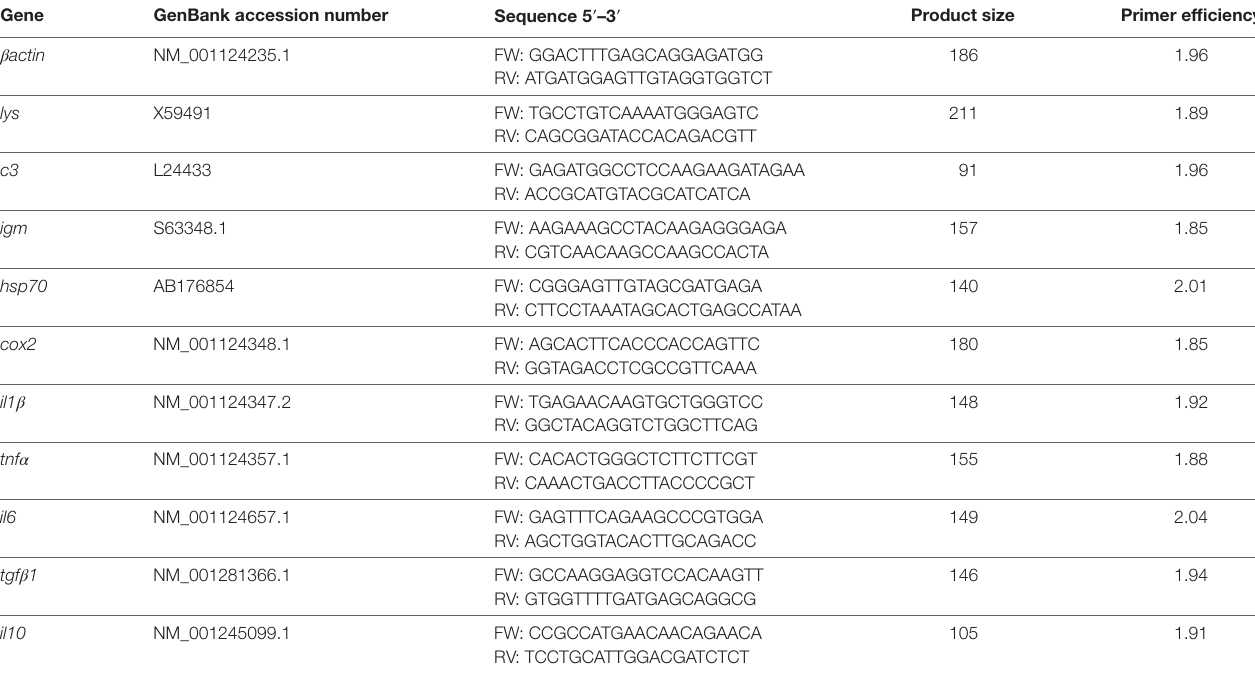
TaBle 1 | Primers used for gene expression analysis in rainbow trout.